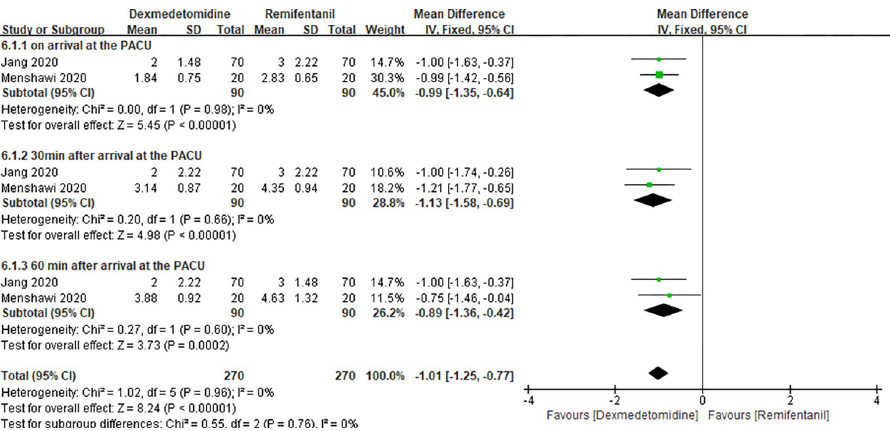
Fig 10. Forest plot of VAS at the PACU. Dexmedetomidine group vs. remifentanil